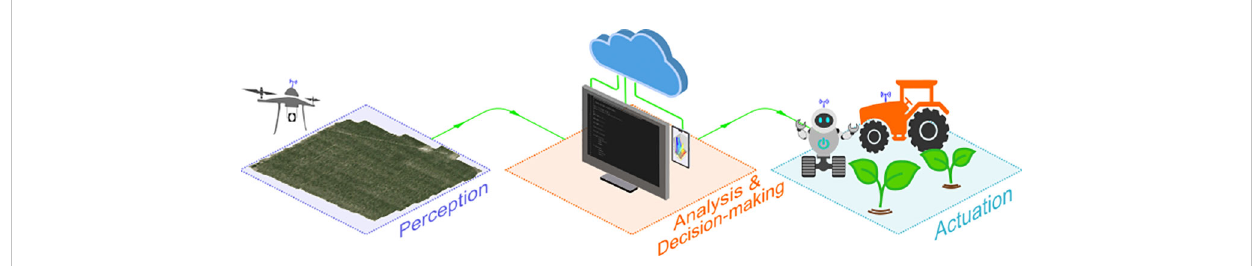
FIGURE 1 The main stages of precision crop